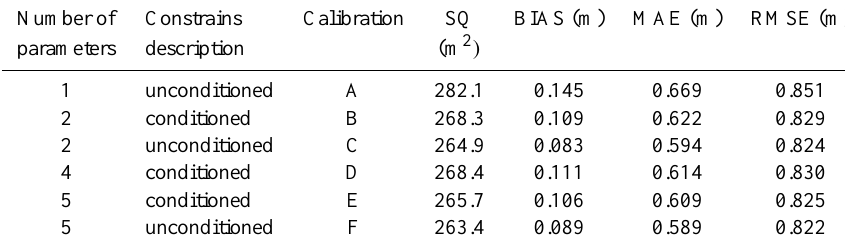
Table 3. Goodness of fit indexes of the different calibration runs using all data